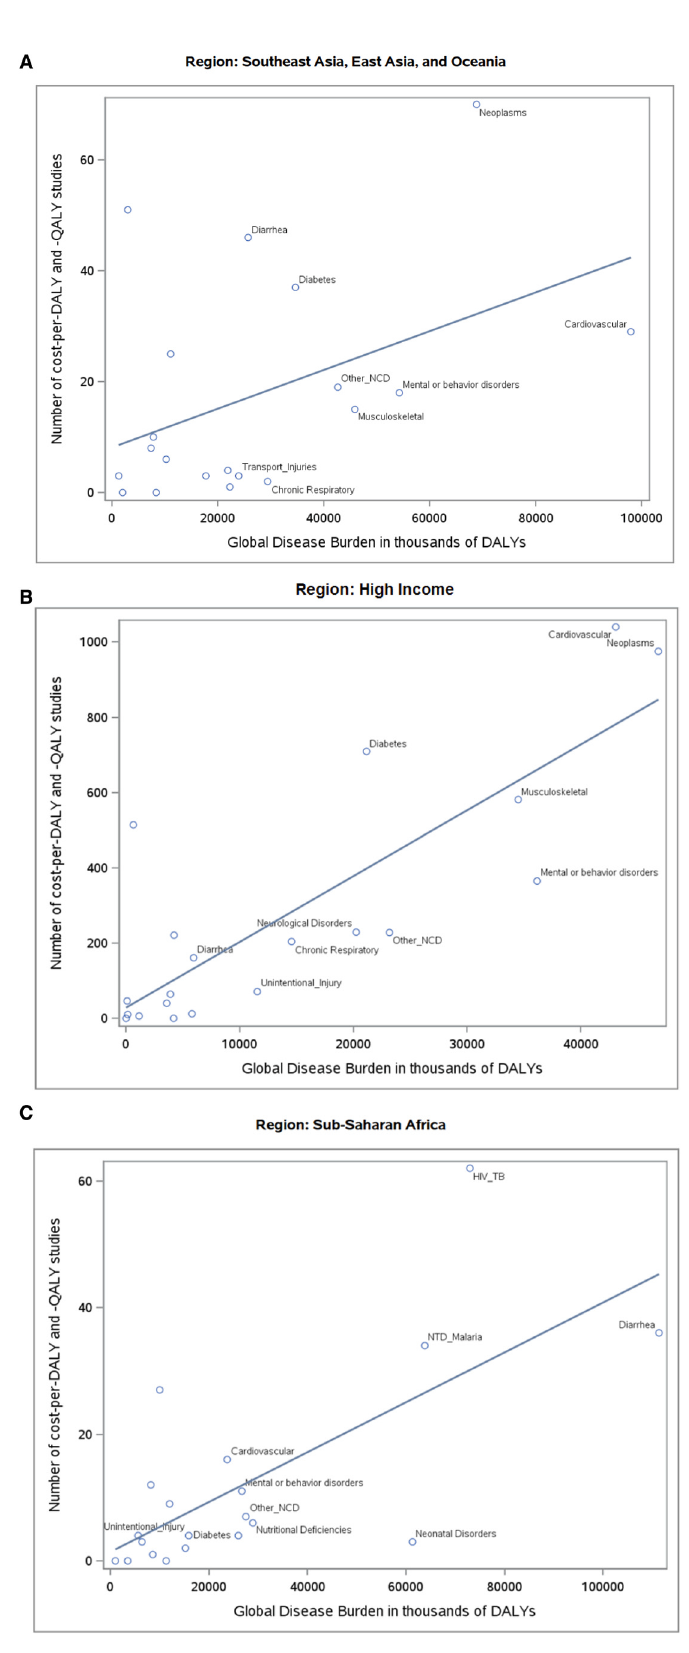
Figure 4. Number of CEAs vs. normalized disease burden for selected diseases and GBD Super Regions. ( A ) Southeast Asia, East Asia, and Oceania. ( B ) High Income Countries. ( C ) Sub-Saharan